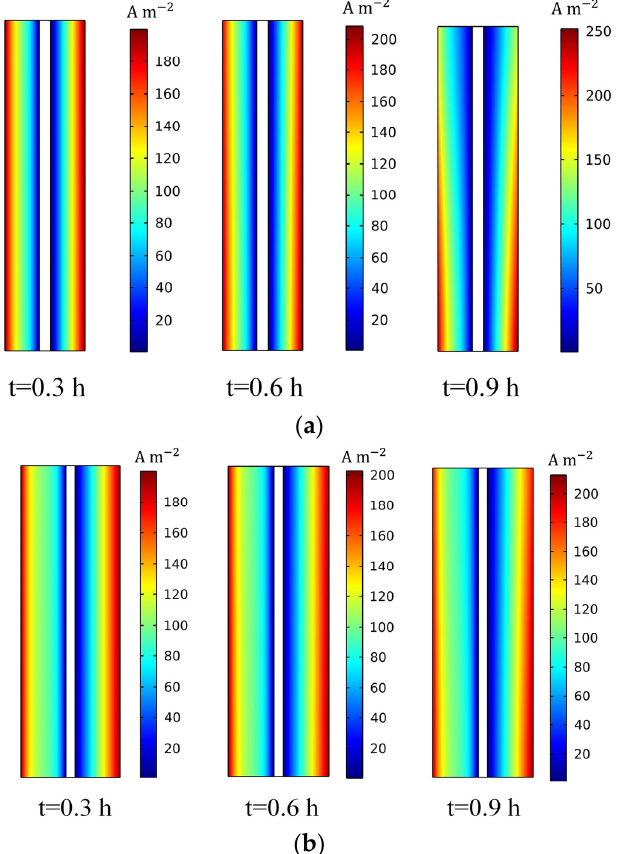
Figure 17. Comparison of electrode current density distribution at different moments at a current density of 20 mA cm − 2 : ( a ) Pristine and ( b ) Optimization.